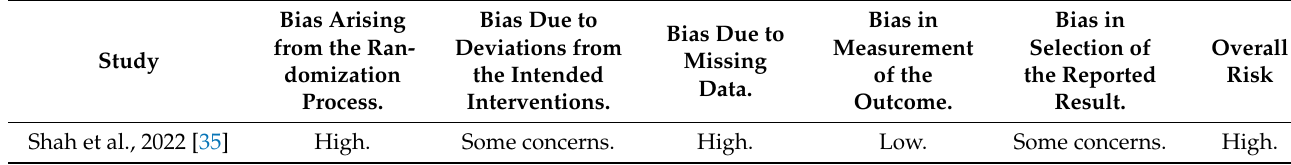
Table 3. Risk of bias assessment for the in vivo study using the RoB-2.0